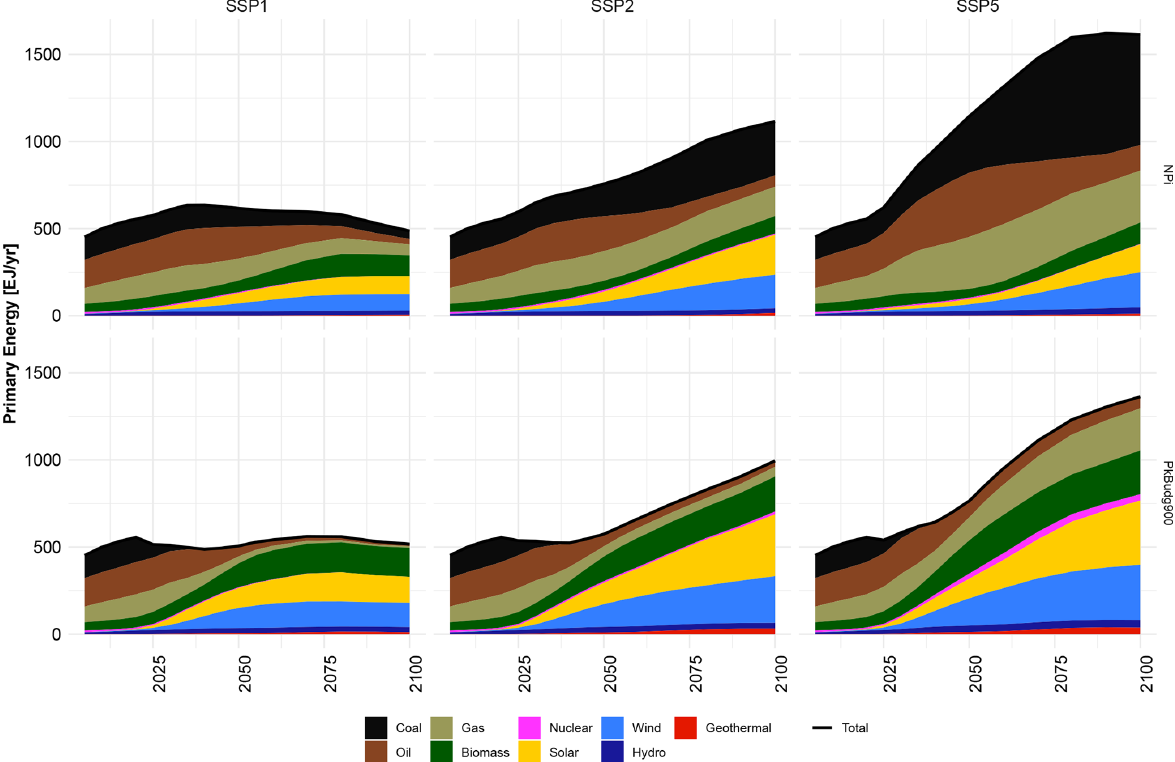
Figure 7. Primary energy mixes by carrier for the NPi and pkBudg900 (1.5 ◦ C) scenario of SSP1, SSP2, and SSP5.